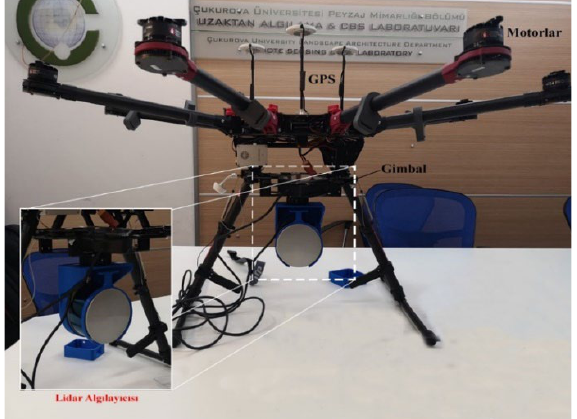
Figure 7 Lidar sensors on unmanned aerial vehicles Generating 3D with Radar